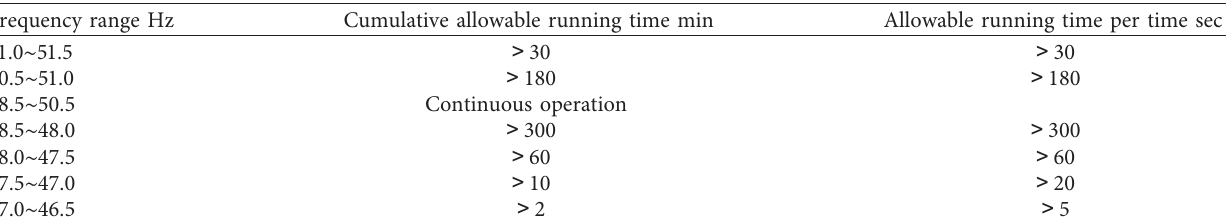
Table 2: Allowable operation time of abnormal frequency.